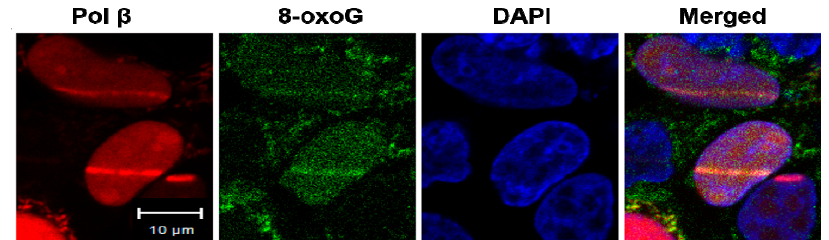
Figure 3. Pol β is recruited to 8-oxoGs in cells: Micro-irradiation was employed to induce 8-oxoGs in HEK293H cells that were transfected with a plasmid expressing mCherry-tagged human pol β . Pol β -mCherry was recruited (red), and 8-oxoG stained with an anti-8-oxoG antibody (green) was generated 4 min after micro-irradiation damage. The nucleus was stained with DAPI (blue). The experiments were done in triplicate.